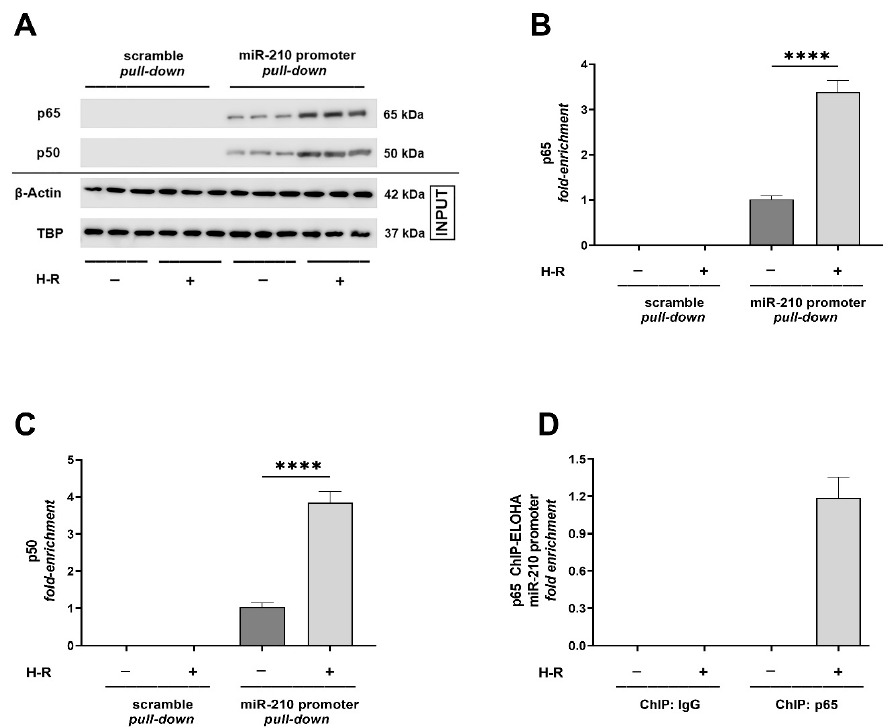
Figure 1. Hypoxia–reoxygenation (H-R) challenge elicits a significant increase in the association and binding of NF- κ B at the miR-210 proximal promoter. ( A – C ) miR-210 promoter pull-down assay determining the quantitative enrichment of the p65 NF- κ B and p50 NF- κ B subunits in the reverse crosslinked miR-210 promoter pull-down fragment. Representative Western blots ( A ) and quantitative densitometric analysis ( B , C ) showing the relative quantitative abundance of p65 NF- κ B and p50 NF- κ B subunits in the miR-210 promoter pull-down lysates. ( D ) Tandem ChIP-ELOHA analysis showing the relative enrichment of p65 NF- κ B at the κ B response element in the miR-210 proximal promoter. Data from the Western blot-coupled densitometric analysis are expressed as mean fold change ± S.D. from three biological replicates belonging to each experimental group ( n = 3). Data from the ChIP-ELOHA analysis are expressed as fold enrichment by first correcting the p65 NF- κ B-associated miR-210 promoter fragment ELOHA absorbance values to the respective inputs , followed by normalization to fold change values. Data from the ChIP-ELOHA analysis are depicted as mean fold enrichment ± S.D. from three technical replicates for each of the four biological replicates belonging to each experimental group ( n = 4). **** p ≤ 0.0001. S.D.: standard deviation.